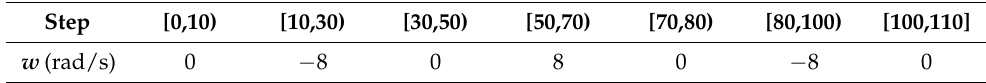
Table 1. Maneuverable process of the target in DS.